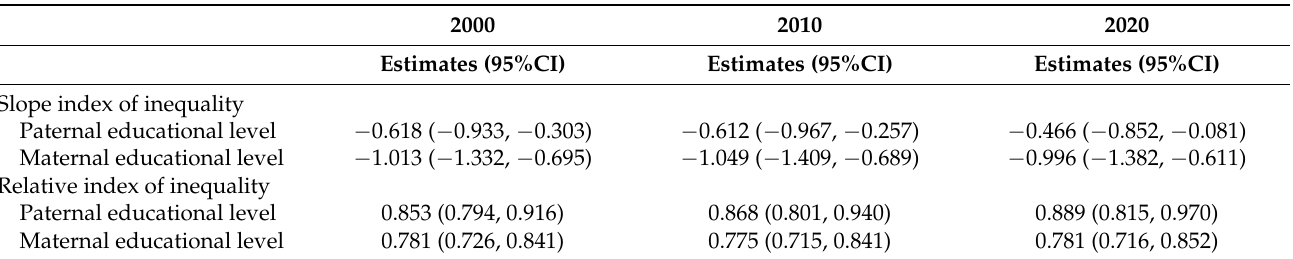
Table 3. Results of slope index of inequality and relative index of inequality for preterm birth rate depending on parental educational